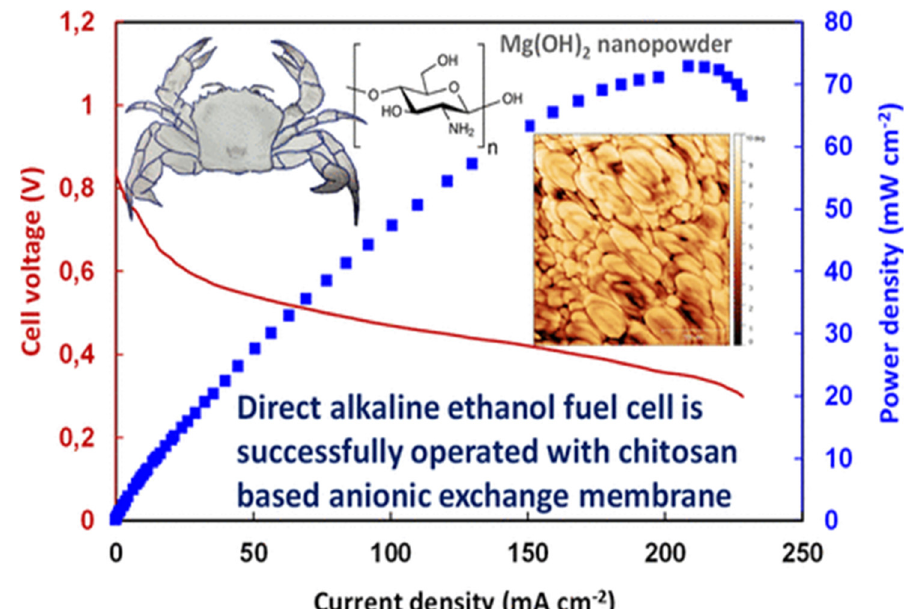
Figure 10. Novel polymer nanocomposite for alkaline fuel cells. Nanocomposite was fabricated using a solvent-casting method in which chitosan, GO, Mg(OH) 2 and benzyltrimethylammonium chloride were used [169].